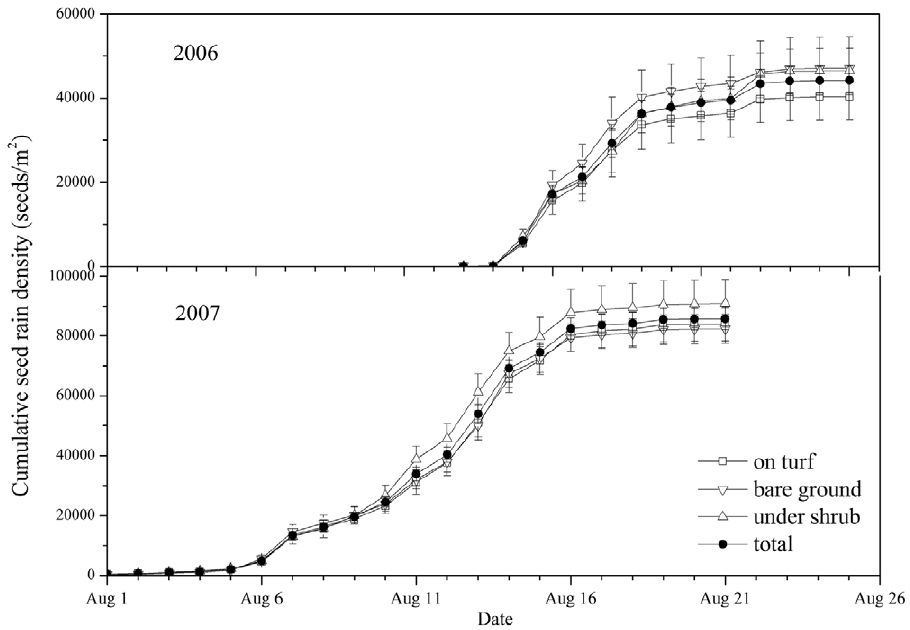
Figure 1. Cumulative seed rain density in plot 1 in 2006 and 2007.